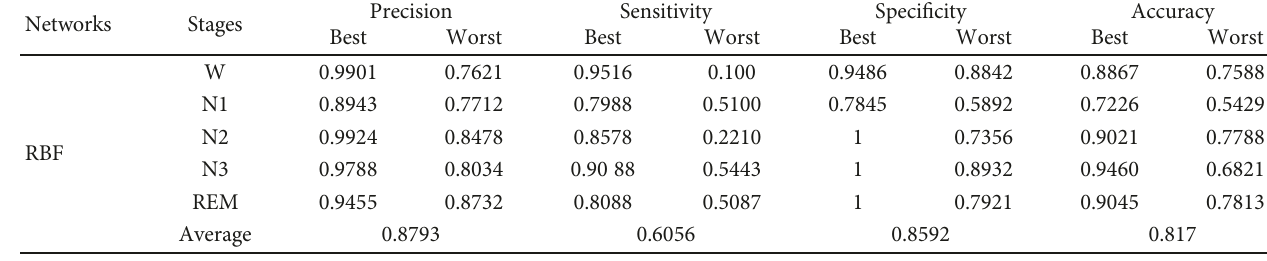
Table 4: Evaluation results of our previous work using RBF.